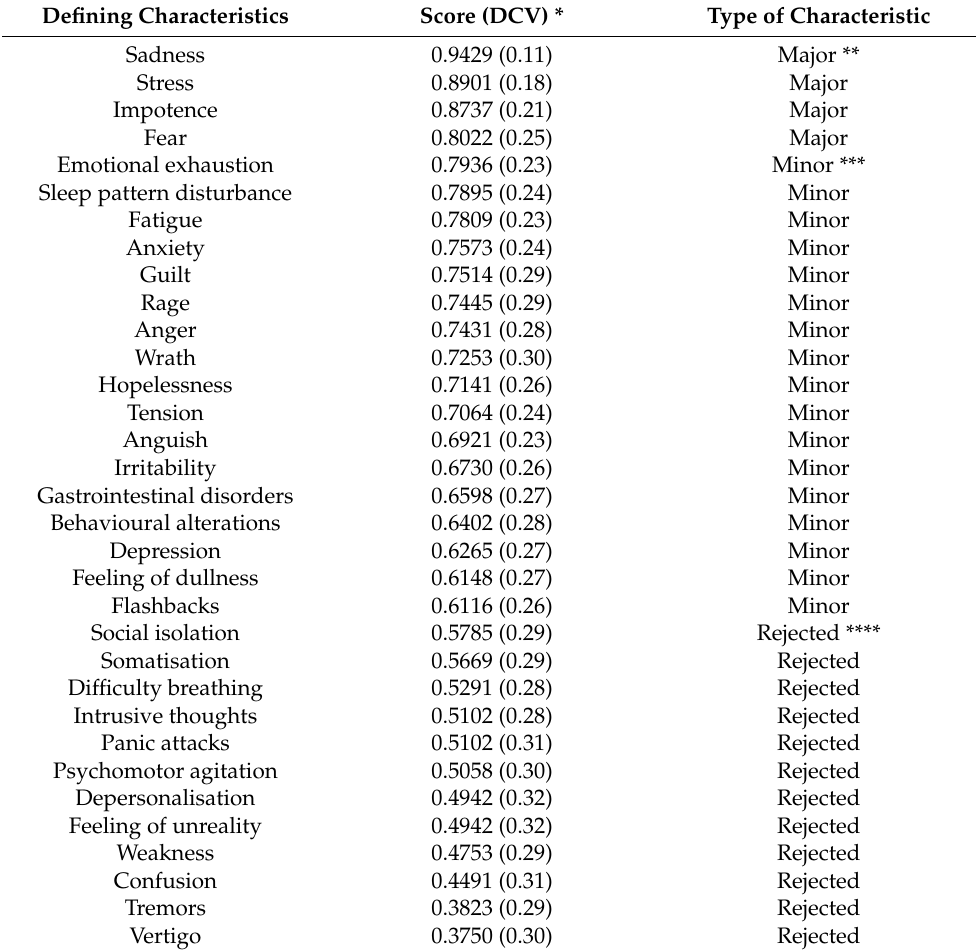
Table 2. DCV scores for each of the defining